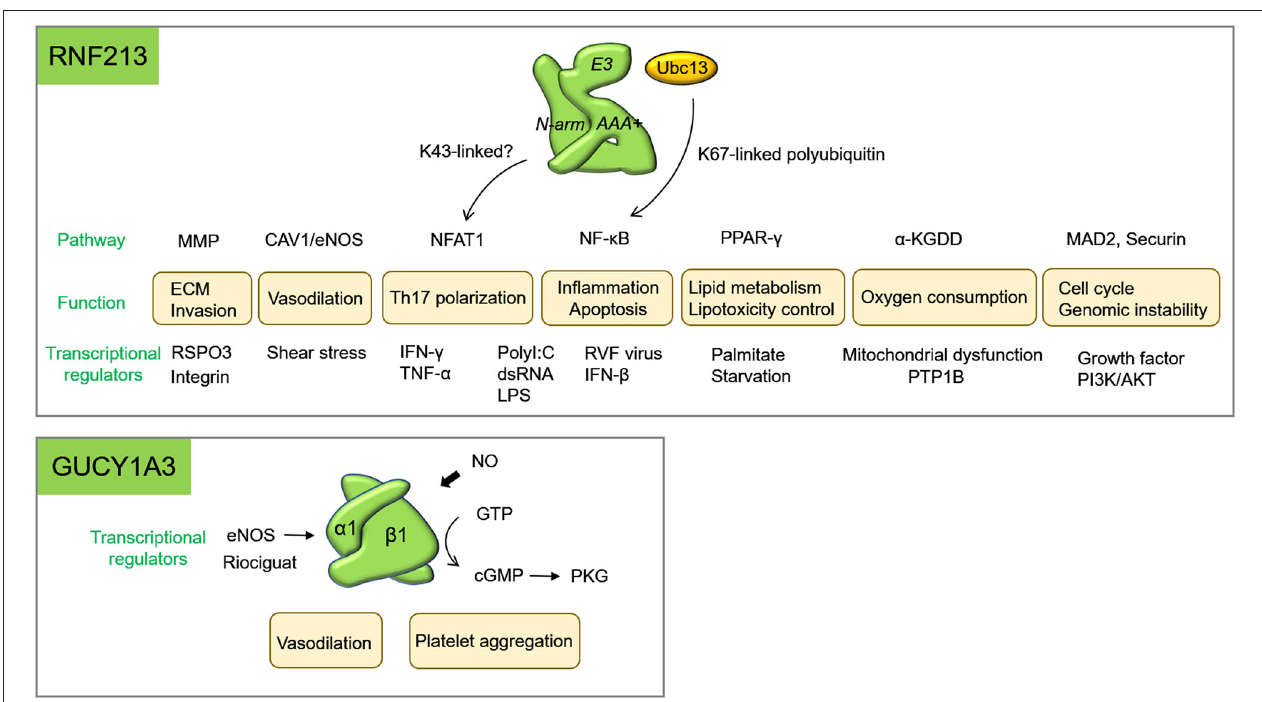
FIGURE 2 | Diverse biological functions of RNF213 and GUCY1A3. Biological functions and their related molecules were shown. Transcriptional regulators of RNF213 for each function were listed below. α -KGDDs represents α -Ketoglutarate-dependent dioxygenases; ECM, extracellular matrix; PDE, phosphodiesterase; RVF, Rift Valley